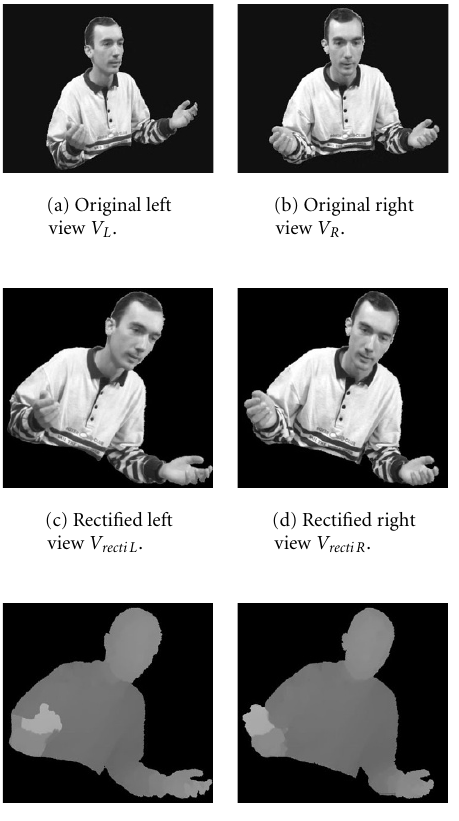
Figure 12: The di ff erence image, between the view V 3 and V D in Figure 11 considering only pixels within the area containing the talking person, together with its histogram are shown here to check the consistency of the reconstructed view with the real-perceived view at the novel viewpoint.